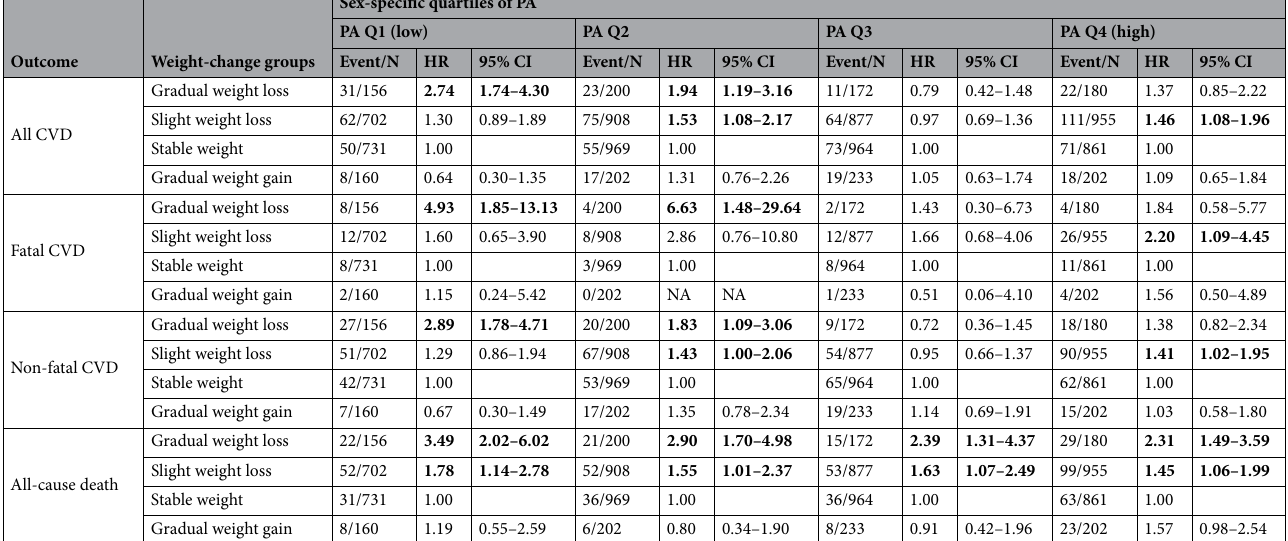
Table 2. Association between weight trajectory and incident CVD and all-cause mortality by physical activity level (crude model). Significant values are in bold. CVD cardiovascular disease, PA physical activity, HR hazard ratio, 95% CI 95% confidence